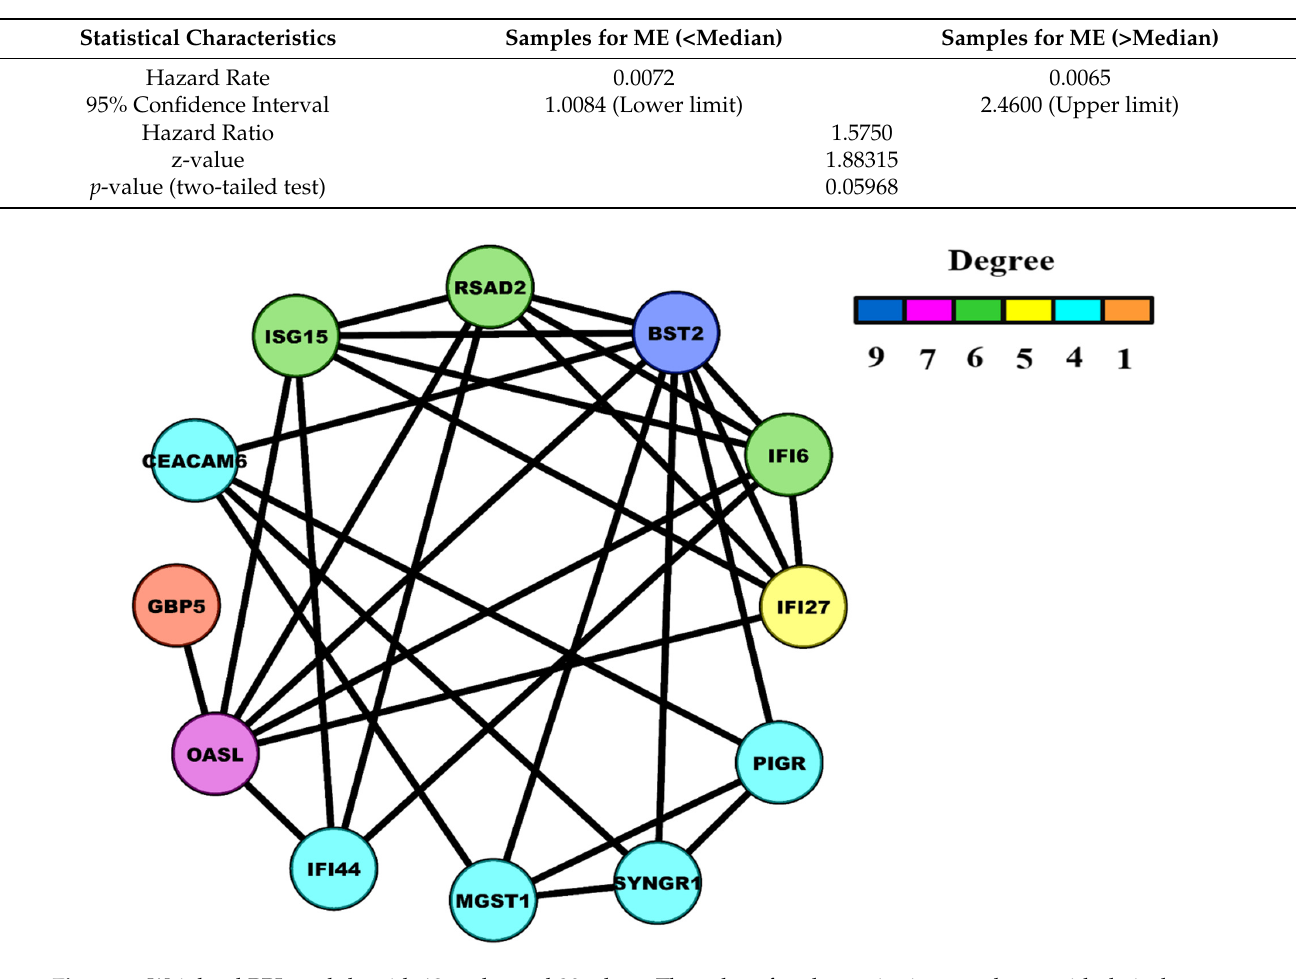
Table 2. Statistical values of log-rank test for the test dataset corresponding to Figure 4B.